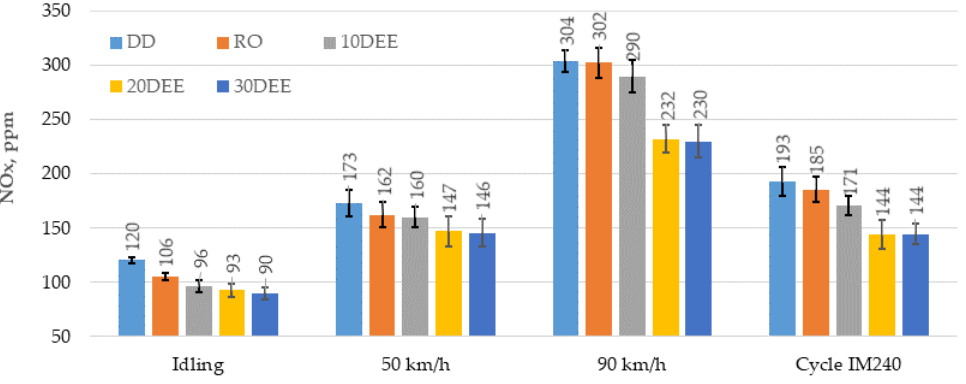
Figure 8. NOx emissions of DD, RO, 10DEE, 20DEE and 30DEE in different testing conditions.